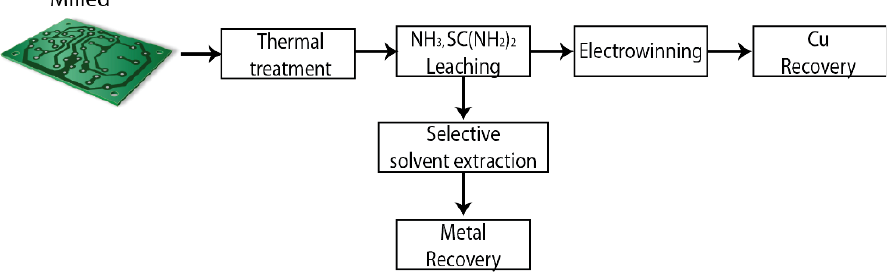
Figure 3. Recovery of PCB metals based on hydrometallurgy with ammonia leaching and thiourea leaching .